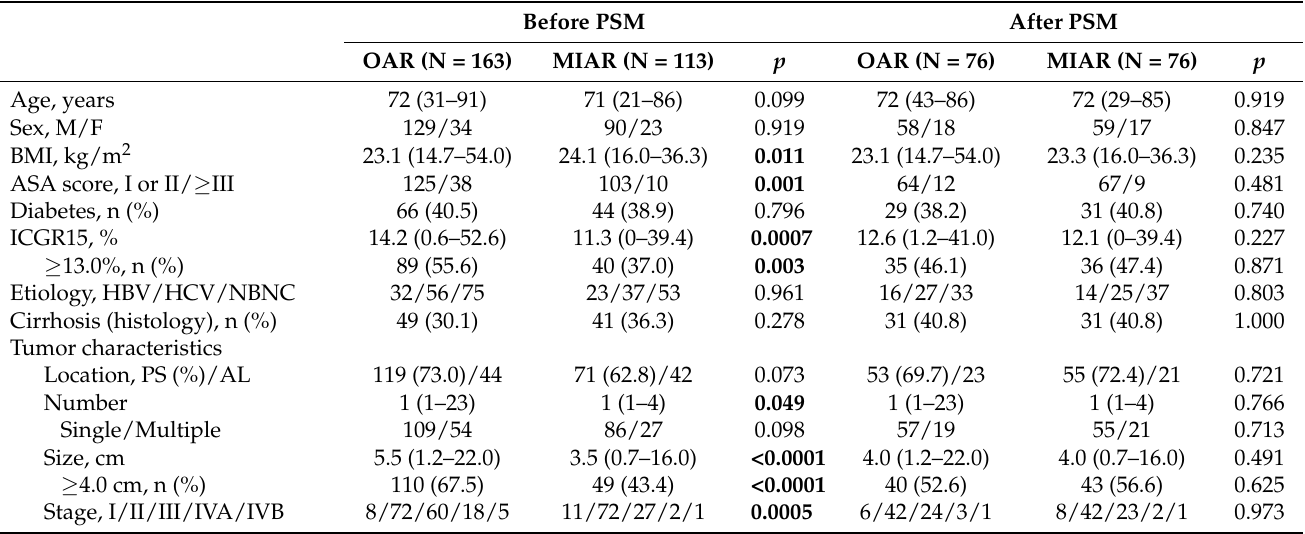
Table 5. Comparison of background data between open and minimally invasive AR for newly developed